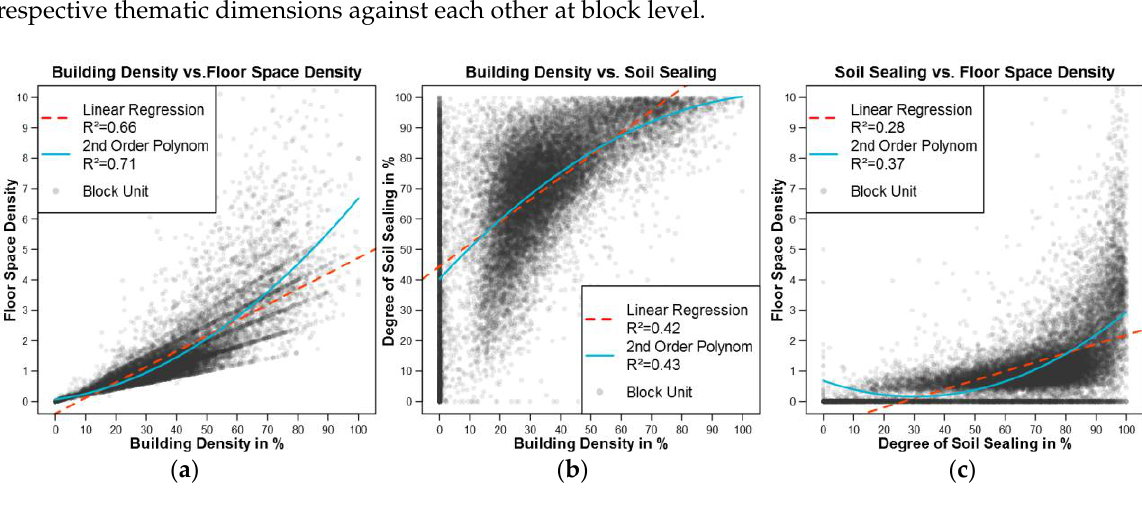
Figure 7. The influence of varying grid sizes on density measures calculated for gross densities.